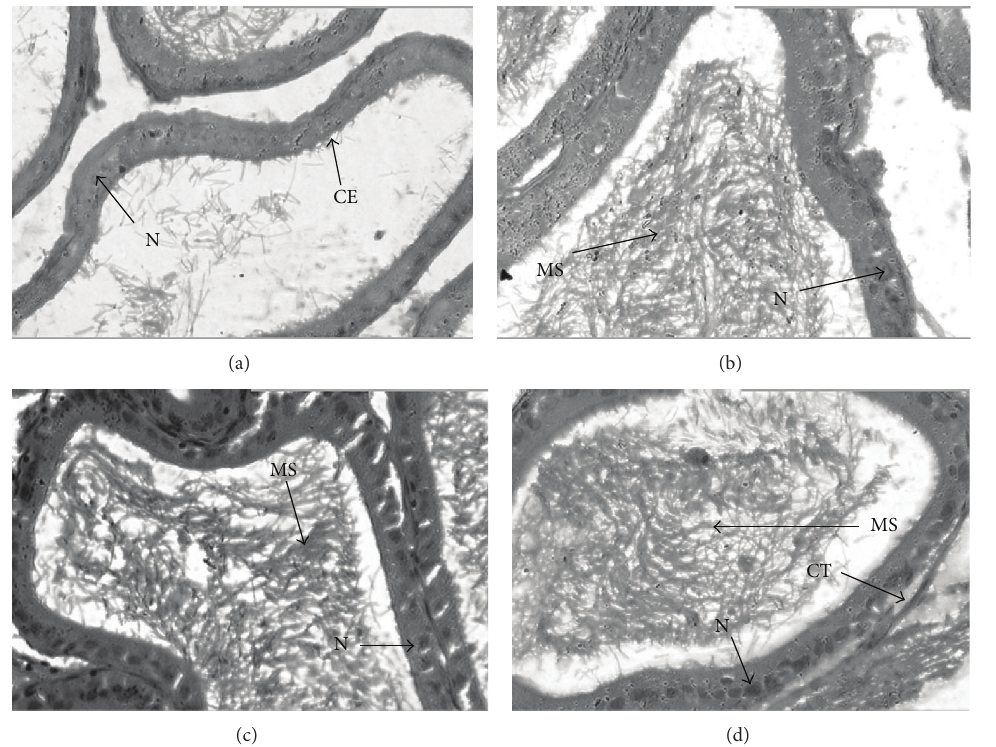
Figure 3: Effect of ethanolic extract of Pueraria tuberosa on histology of epididymis, (a) Control group. (b) Ethanolic extract 50 mg/kg. (c) Ethanolic extract 100mg/kg. (d) Ethanolic extract 150 mg/kg treated groups. MS: mobile spermatozoa; N: nucleus; CE: cuboidal epithelium; CT: connective